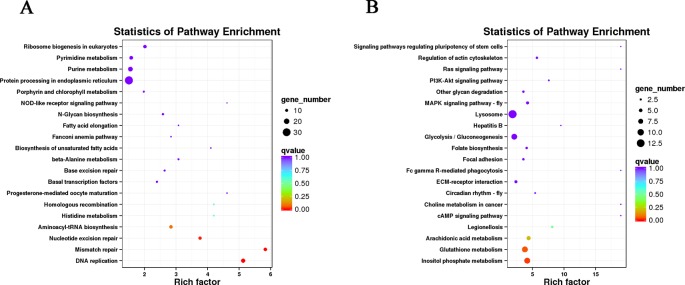
Pathway enrichment of differentially expressed transcripts in muscle (A) and gonad (B). Each circle represents a Kyoto Encyclopedia of Genes and Genomes pathway. The vertical axis displays the pathway name and the horizontal axis represents the enrichment factor, which indicating the ratio of the proportion of transcripts annotated into a certain pathway in differentially expressed transcripts (DETs) to the proportion of transcripts annotated into that pathway in all transcripts. A higher enrichment factor represents a more significant enrichment level of DETs in this pathway. The color of the circle represents q-value, which is the P value after correction of multiple hypothesis test. The smaller q-value indicates more reliable enrichment of DET in this pathway. The size of the circle indicates the number of transcripts enriched in the pathway.